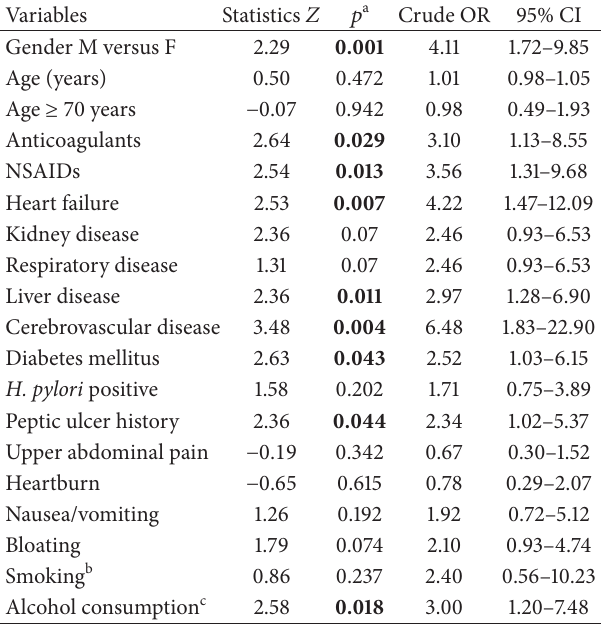
Table 2: Results from univariate binary logistic regression.